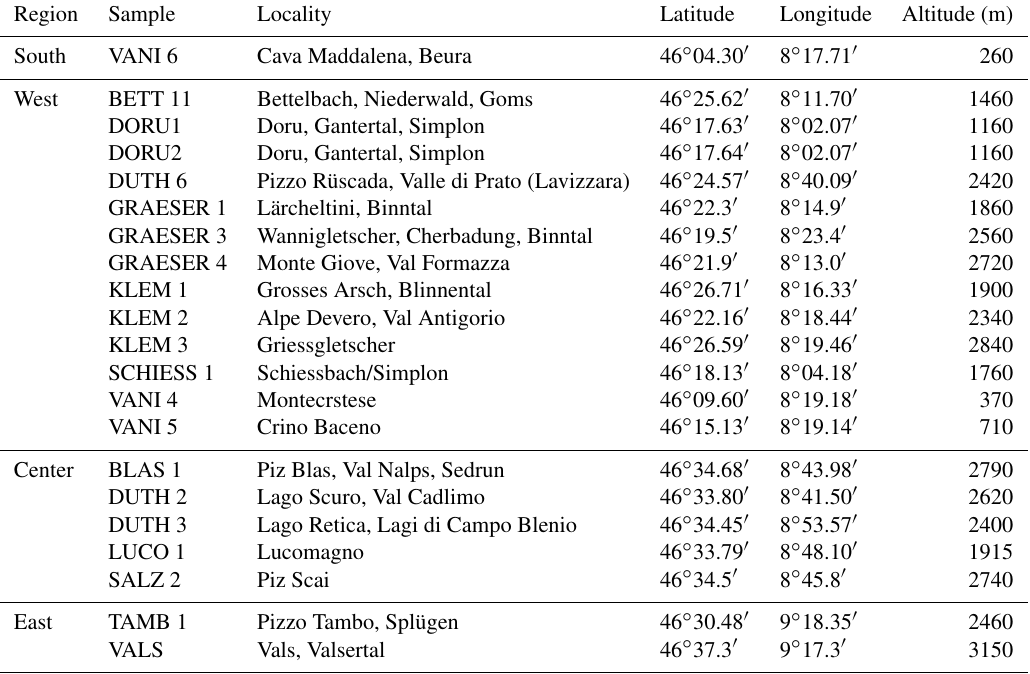
Table 1. Information on sample localities for all analyzed